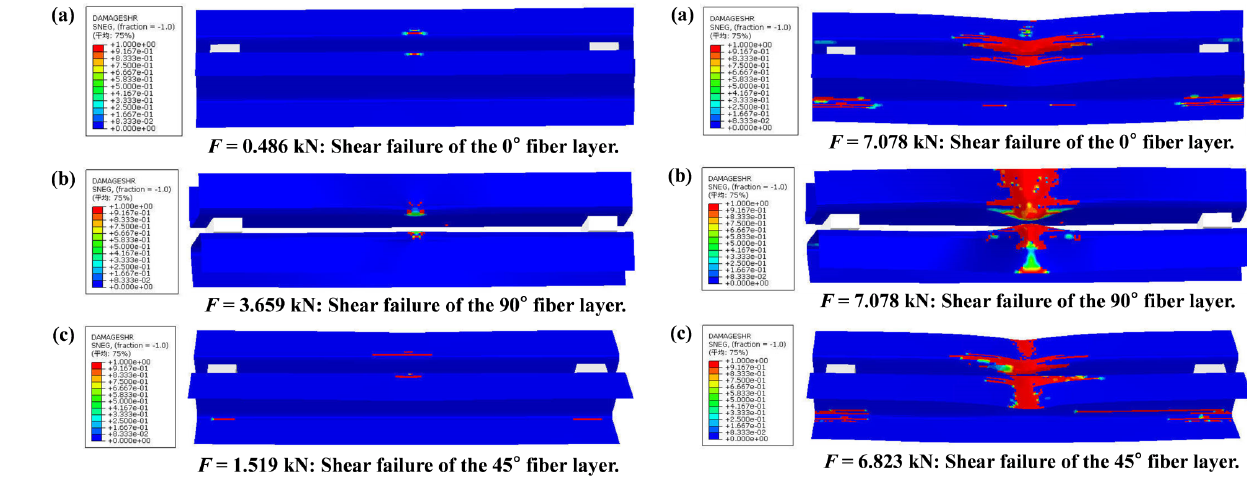
Figure 23: Initial shear failure area distribution of fiber layers: (a) SHCXL-A: 0 ∘ fiber layer; (b) SHCXL-A: 90 ∘ fiber layer; and (c) SHCXL- B: 45 ∘ fiber layer.